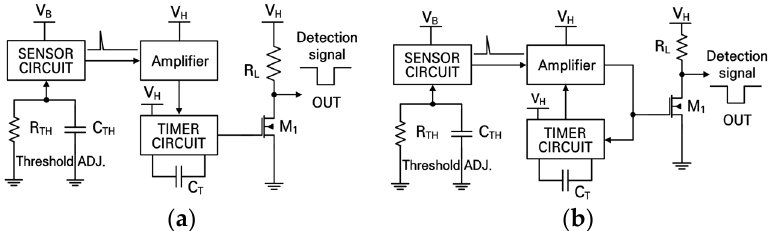
Figure 1. Block diagram of conventional pulsed radiation detection circuits: ( a ) Maxwell’s nuclear event detector and ( b ) timer bypass detection circuit. event detector and ( b ) timer bypass detection